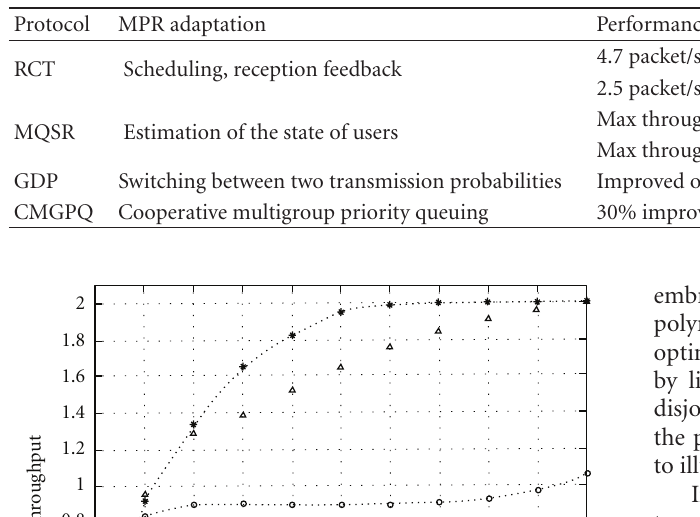
Table 3: MAC with MPR.